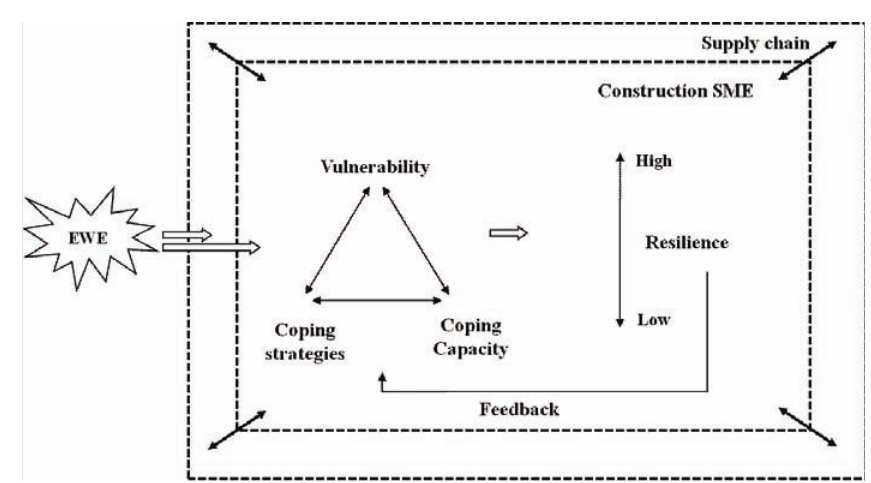
figure 1. conceptual framework of the